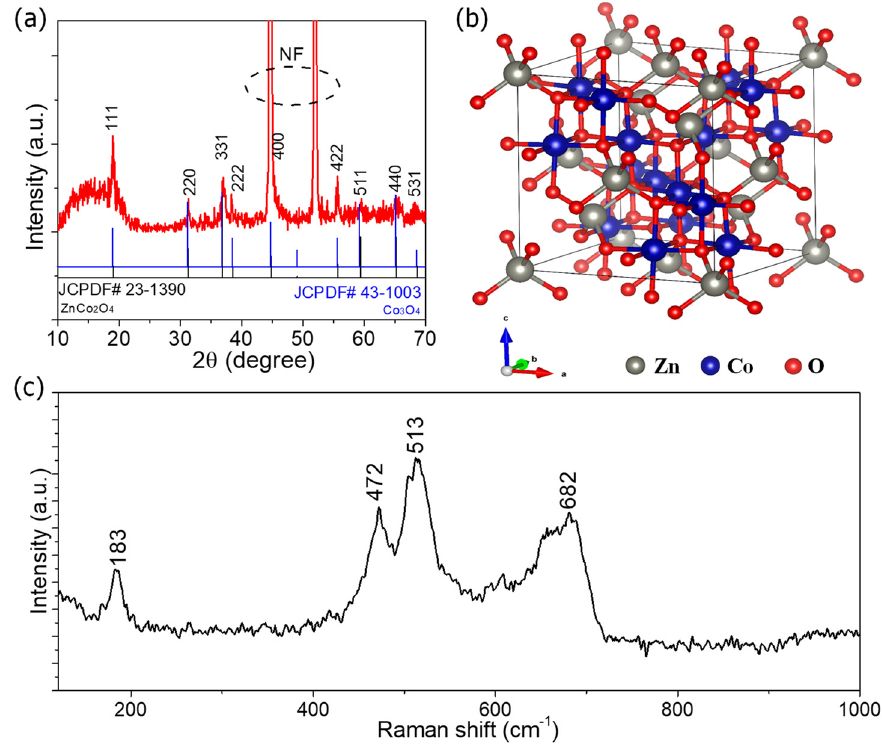
Figure 5. Physical characterizations of ZnCoO@NF: ( a ) xrd pattern, ( b ) crystal structure ( c ) Raman spectra.